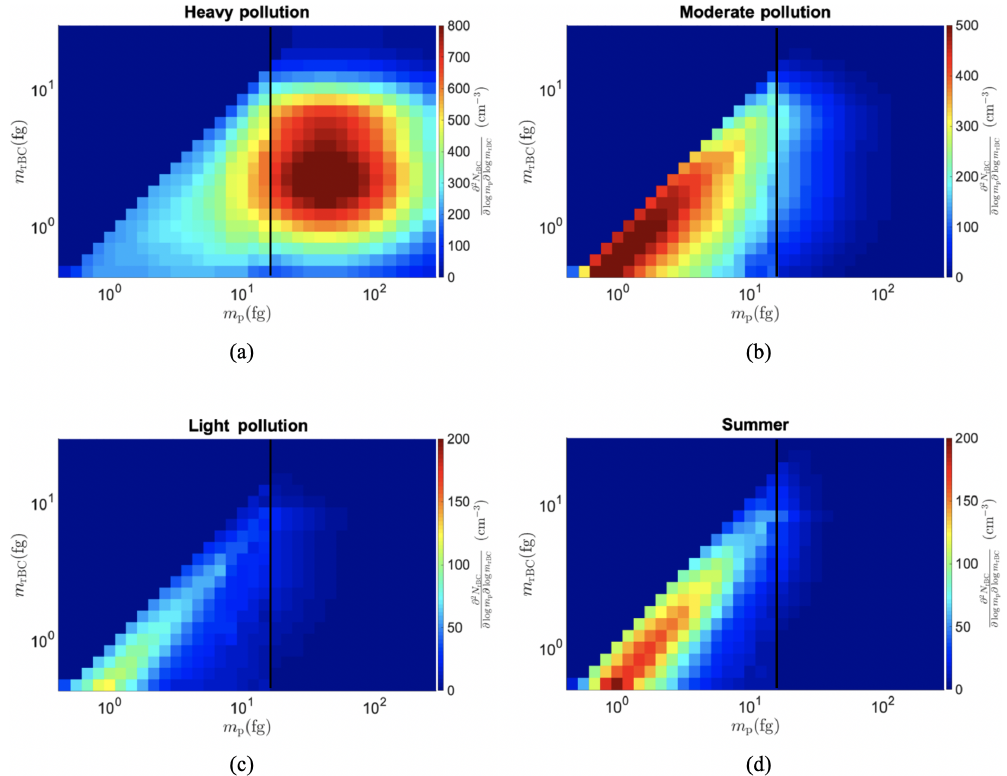
Figure 4. CPMA–SP2 inversion matrix examples under different pollution conditions in winter (a, b, c) , and the example in the summer period (d) ; the x axis, m p , represents the mass of the whole rBC-containing particle, while the y axis, m rBC , represents the mass of the rBC material. The colour bar represents the magnitude of the two-variable distribution with a number concentration unit of cubit centimetres (cm − 3 ). All the bins with m rBC larger than m p are zero since such a particle does not exist in reality, and therefore the two-dimensional function distribution graph has a triangle shape. The black solid line shows where the extrapolation